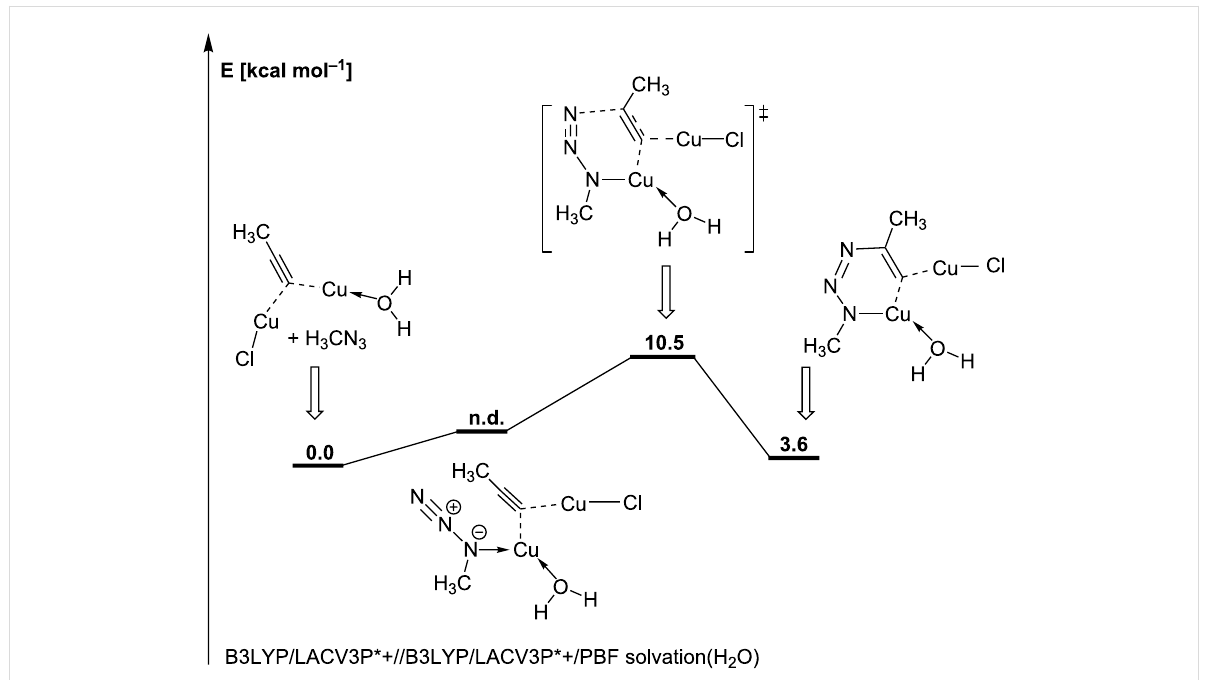
Figure 9: Energy diagram by Ahlquist and Fokin